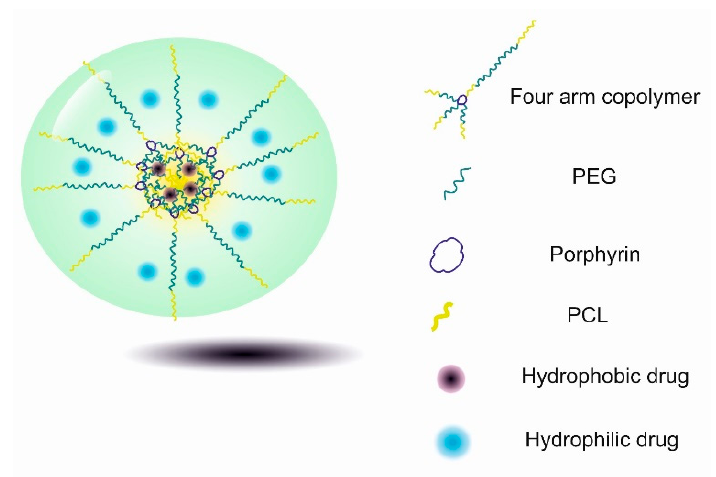
Figure 7. Thermosensitive fluorescent nanogels based on the four-arm PEG–PCL copolymer for co-delivery of hydrophobic and hydrophilic drugs.